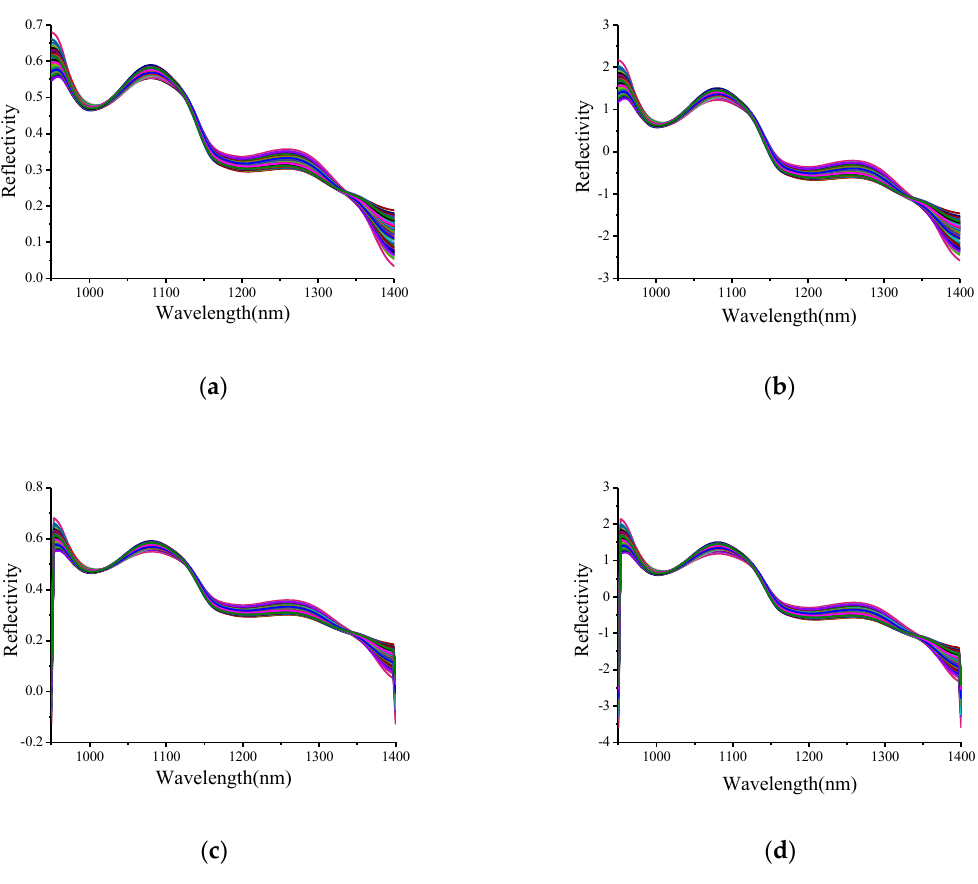
Figure 4. The hyperspectral curves of different pretreatment methods processed for different numbers of cycles: ( a ) MSC; ( b ) SNV; ( c ) S-G-MSC; and ( d ) S-G-SNV.